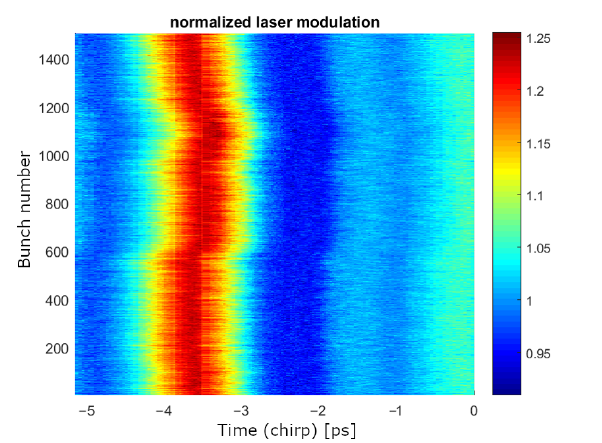
Figure 14. Sensor response to LED illumination through a slit.